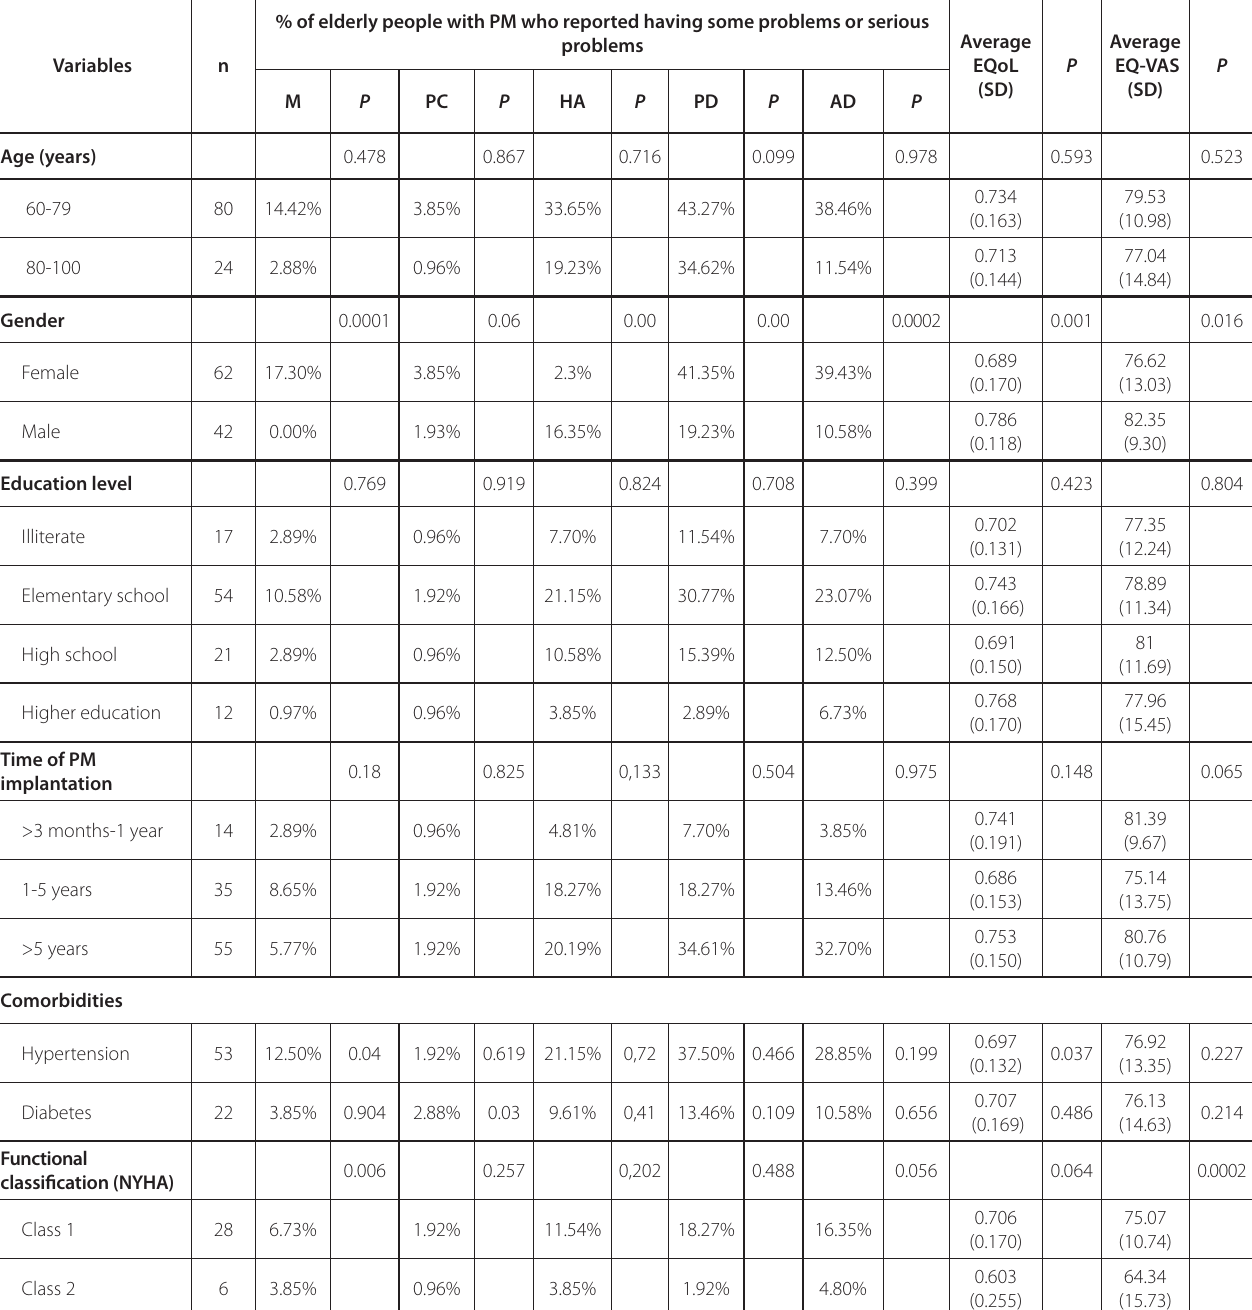
Table 4 . Responses to the EQ-5D according to the demographic variables of elderly people with a pacemaker (PM).